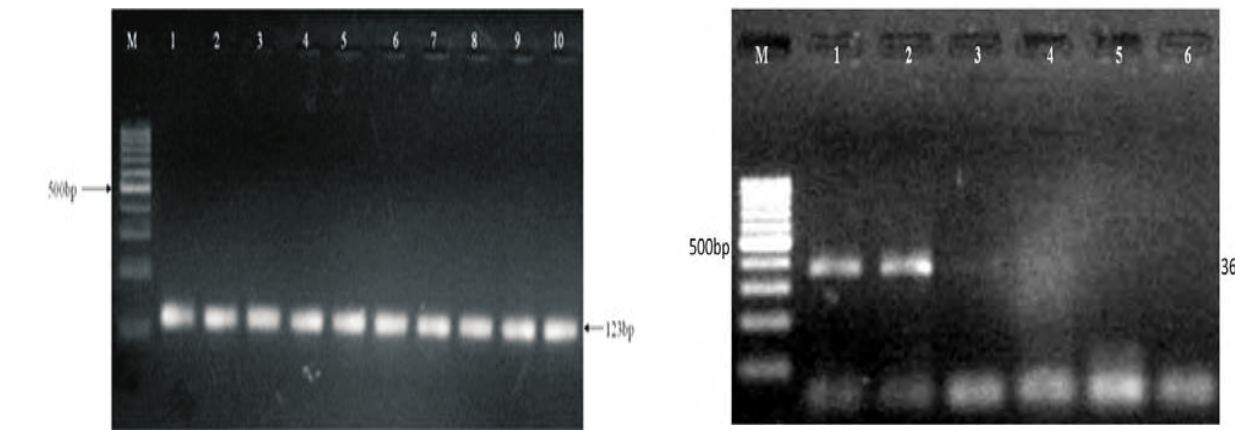
Figure-1. RT-PCR using ns1 gene specific primers to generate 123 bp product. Lanes: M- 100bp ladder; 1- positive control 2 -KMNO7 (BTV-21); The numbers on sides indicate size of PCR product in base pair